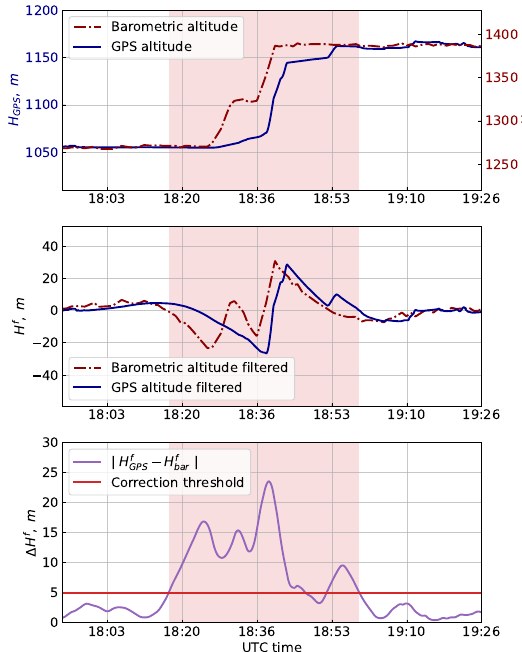
Figure 15. An example of the anomalous GPS altitude behavior, as compared with the ‘barometric’ altitude ( top panel) during flight 2013-2. The same data with a high-pass digital Butterworth filter applied ( middle panel). Smoothed absolute delta of high-passed altitudes from the ( middle panel), used as a gate with the threshold set by the red line ( bottom panel); intervals above this line correspond to the red bands on all panels, which are the intervals subjected to GPS data